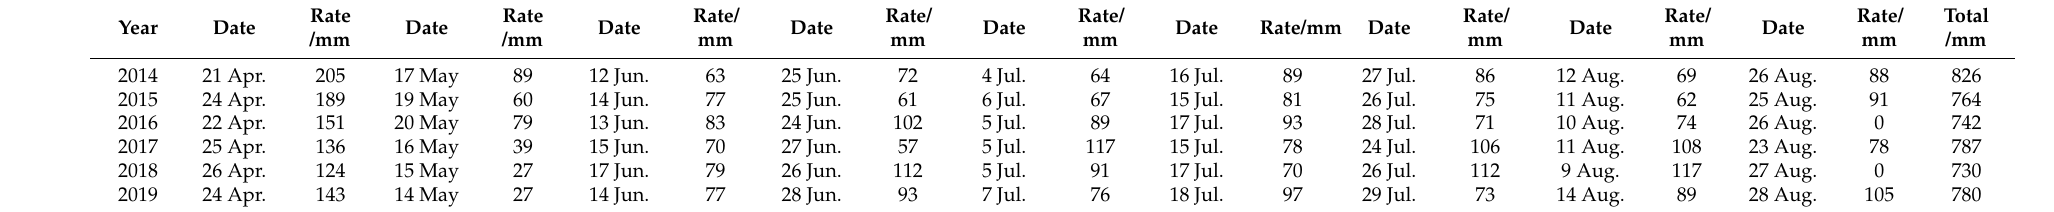
Table 1. The irrigation schedule of cotton in study area in 2014–2019.